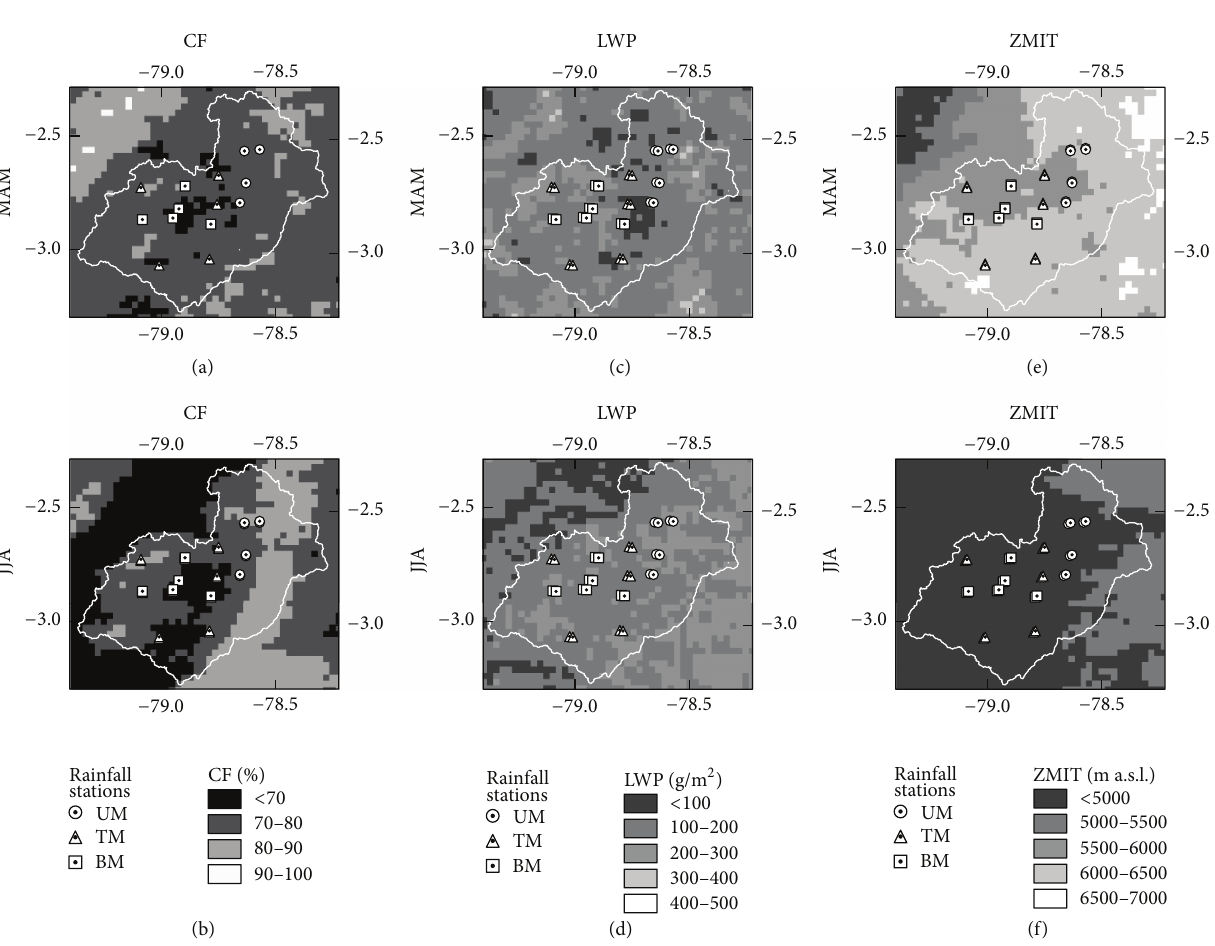
western escarpment of the western cordillera toward the coastal plains, a lee effect is evident during JJA for CF and LWP (Figures 6(b) and 6(d)). The resemblance between CF patterns during JJA with CFM seasonality delineation (Figure 6) is striking, pointing to the importance of the Amazon influence on seasonality of precipitation and climate for the